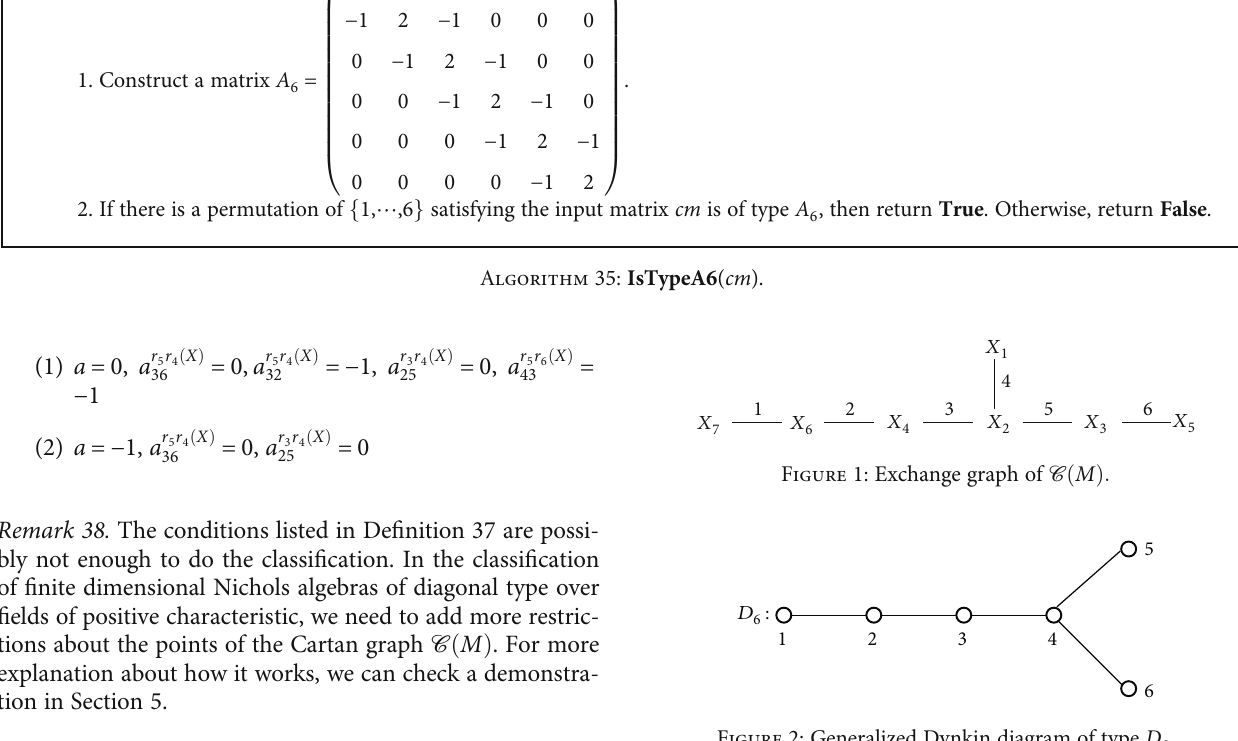
Figure 2: Generalized Dynkin diagram of type D